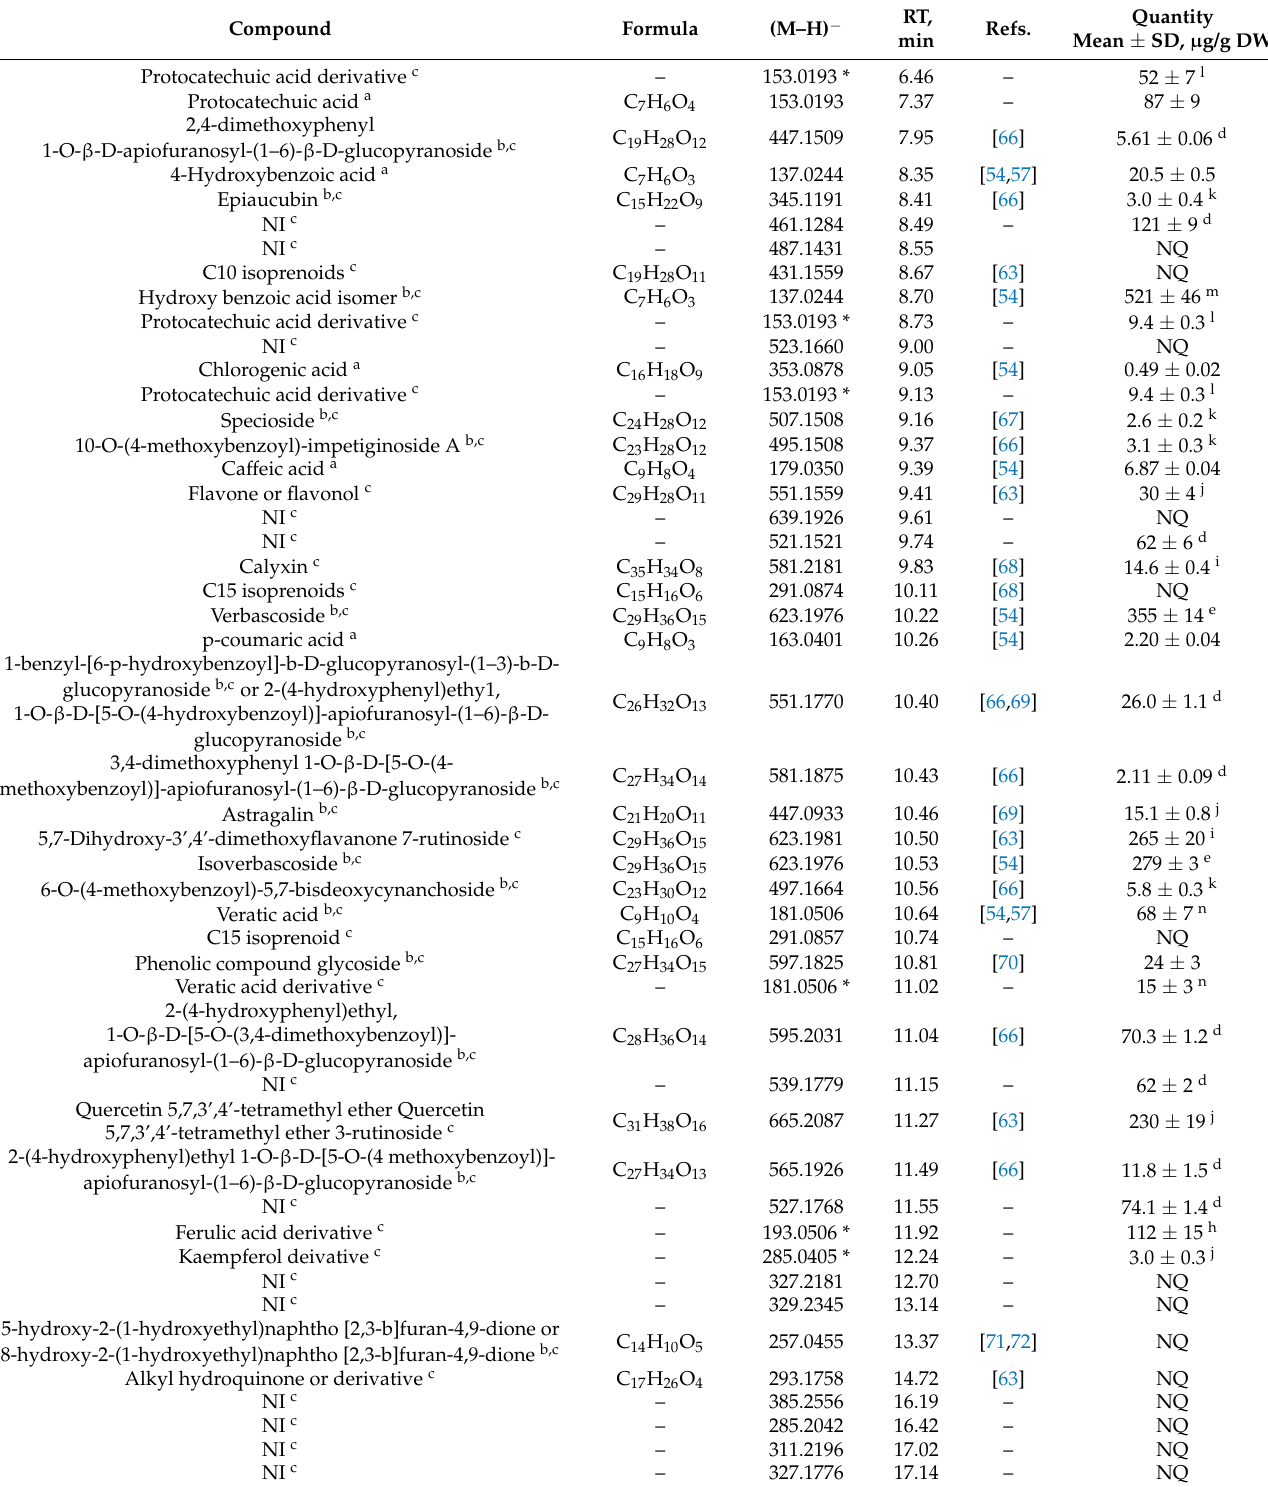
Table 3. Compounds identified in the Tabebuia avellanedae bark